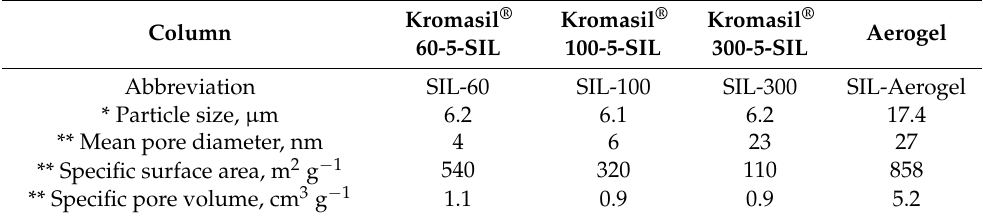
Table 1. Textural properties of the porous materials employed as stationary phases.